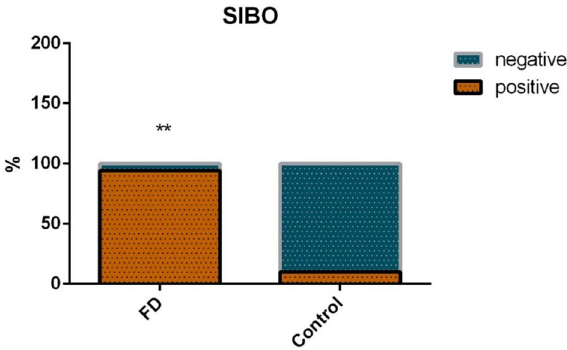
Figure 5. SIBO prevalence in FD and HC